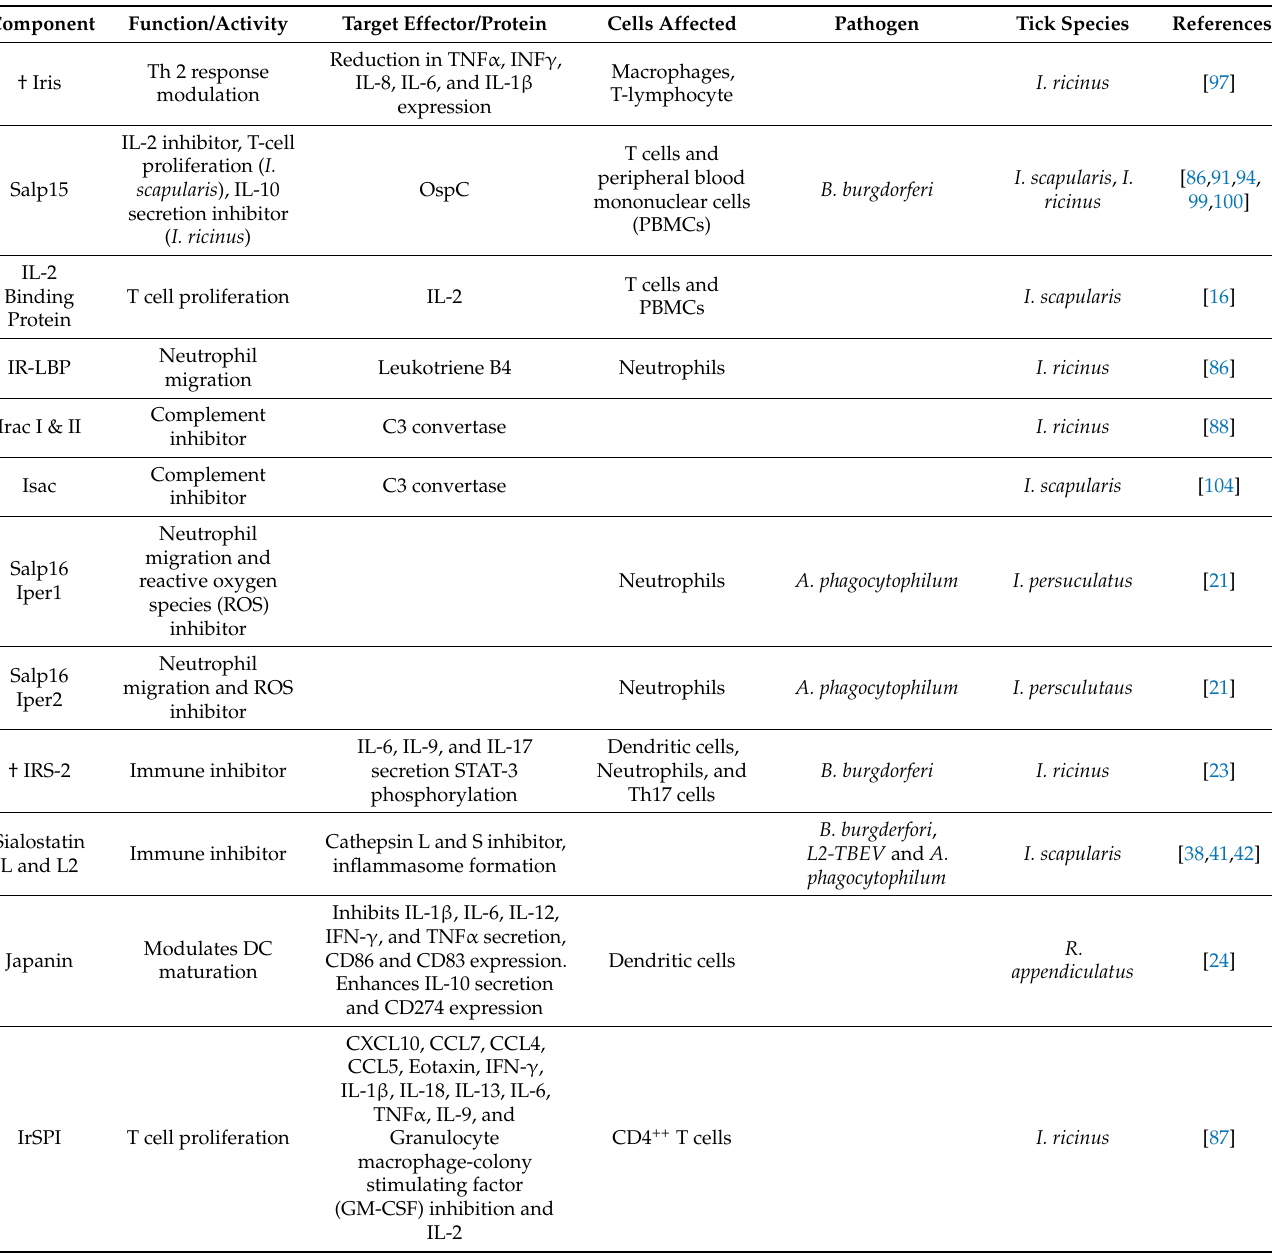
Table 2. Described immunomodulatory components in tick saliva